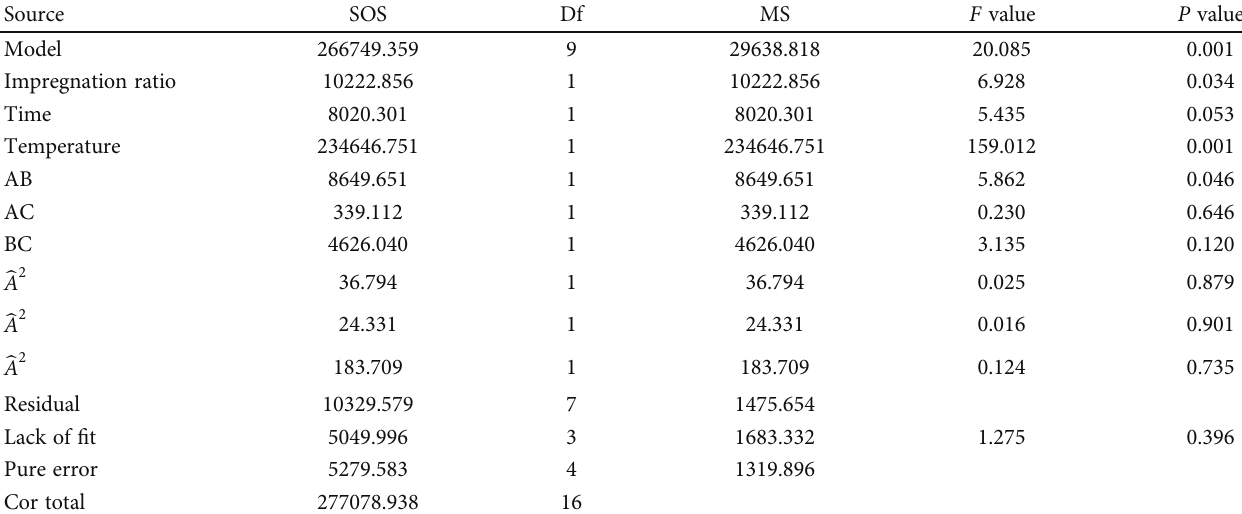
Figure 2: Response 3D surface and contour plots of methylene blue based on the input parameters. Table 2: ANOVA predictions of iodine